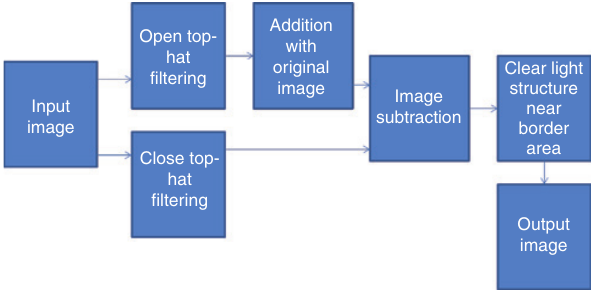
Figure 2: Block Diagram of Proposed Pre-Processing